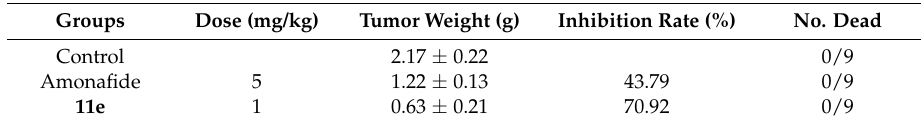
Table 2. In vivo H22 tumor growth inhibitions by 11e